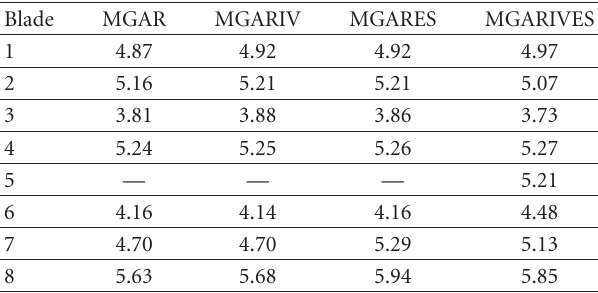
Figure 11: Rig casing with cut-out windows.